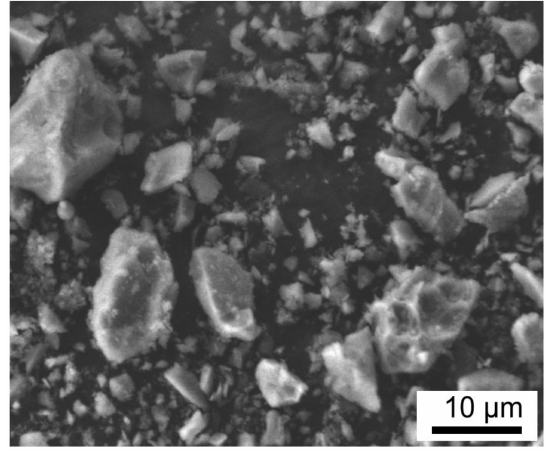
Figure 3. SEM of AYZ powder.